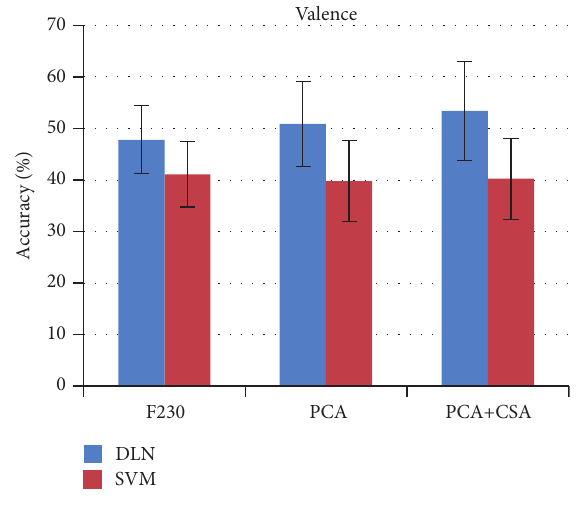
Figure 14: DLN versus SVM valence accuracy.